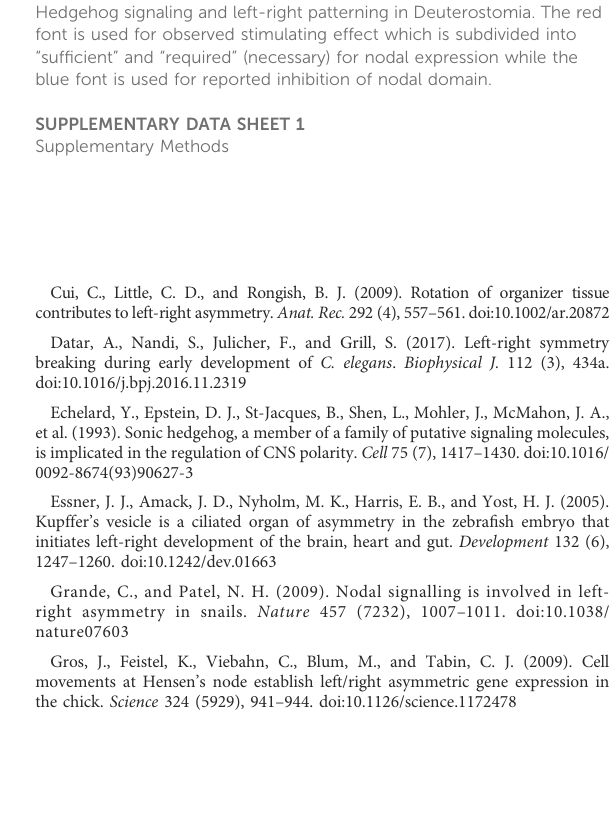
SUPPLEMENTARY TABLE S1 Left – right patterning in SAG-treated embryos and control: nodal and (A) pitx2 (B) expression. SUPPLEMENTARY TABLE S2 Hedgehog signaling in the chick left – right patterning: compilation of previous results concerning the role of hedgehog signaling in left – right patterning in comparison to the present report. SUPPLEMENTARY FIGURE S1 Proposed mechanism of molecular left-right patterning as a consequence of asymmetric node morphogenesis in the chick. (A) : Schematic dorsal view of chick embryo at early stage 5 after node rotation. (B,C) : Transversal sections at levels shown in (A) . The notochord is marked in red, the fl oor plate is labeled in turquoise and blue indicates the paraxial nodal domain. Dashed arrows in (A) indicate a shift of the node during notochord elongation and concomitant streak regression, black arrow in (C) indicates the proposedinductionof theparaxial nodal expression by shhfrom the notochord, green arrow in (C) indicates the proposed subsequent induction of nodal expression in the prospective lateral plate mesoderm (lpm) by nodal ligand from the paraxial domain. A is modi fi ed version of Figure 7B published in (Kremnyov et al., 2018). SUPPLEMENTARY FIGURE S2 Hedgehog signaling and left-right patterning in Deuterostomia. The red font is used for observed stimulating effect which is subdivided into “ suf fi cient ” and “ required ” (necessary) for nodal expression while the blue font is used for reported inhibition of nodal